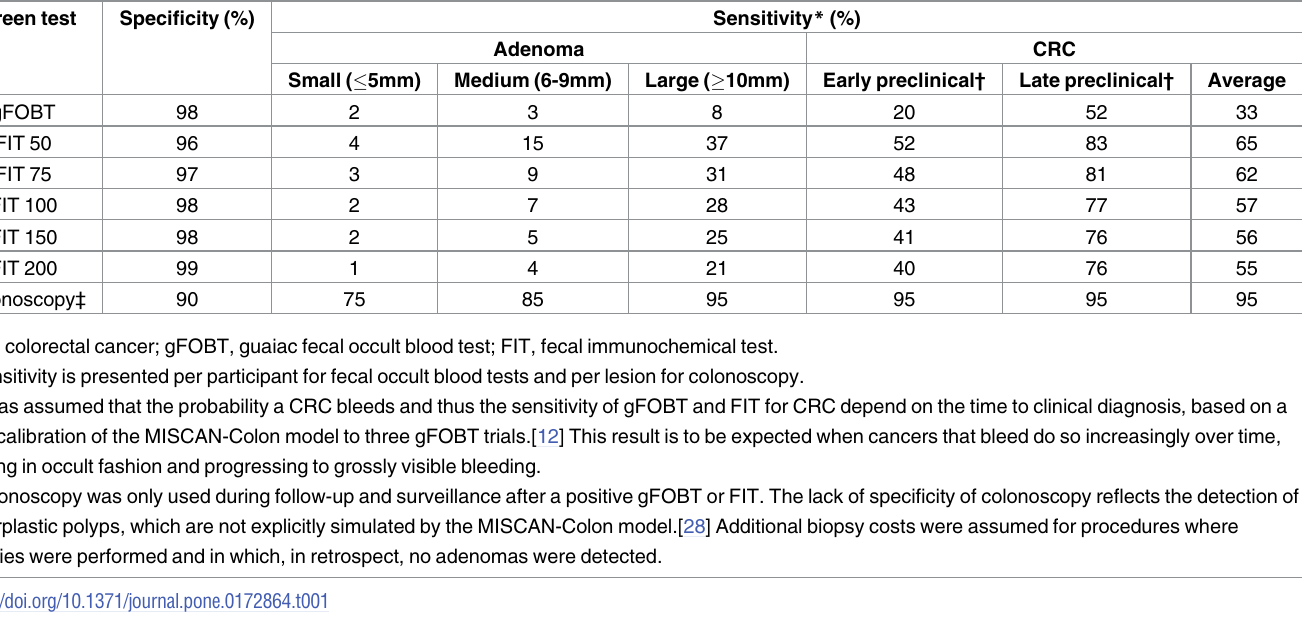
Table 1. Test characteristics of the screening tests used in the